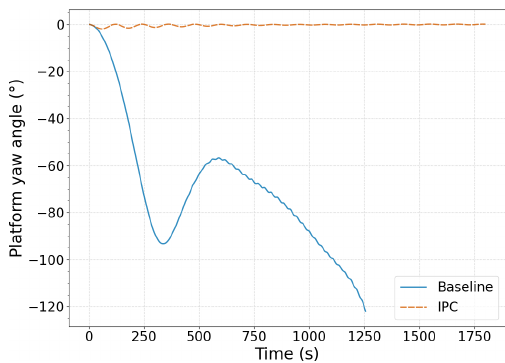
Figure 10. Platform yaw angle with (dashed orange) and without yaw-by-IPC loop (solid blue) and an NWP wind speed of 20ms − 1 .